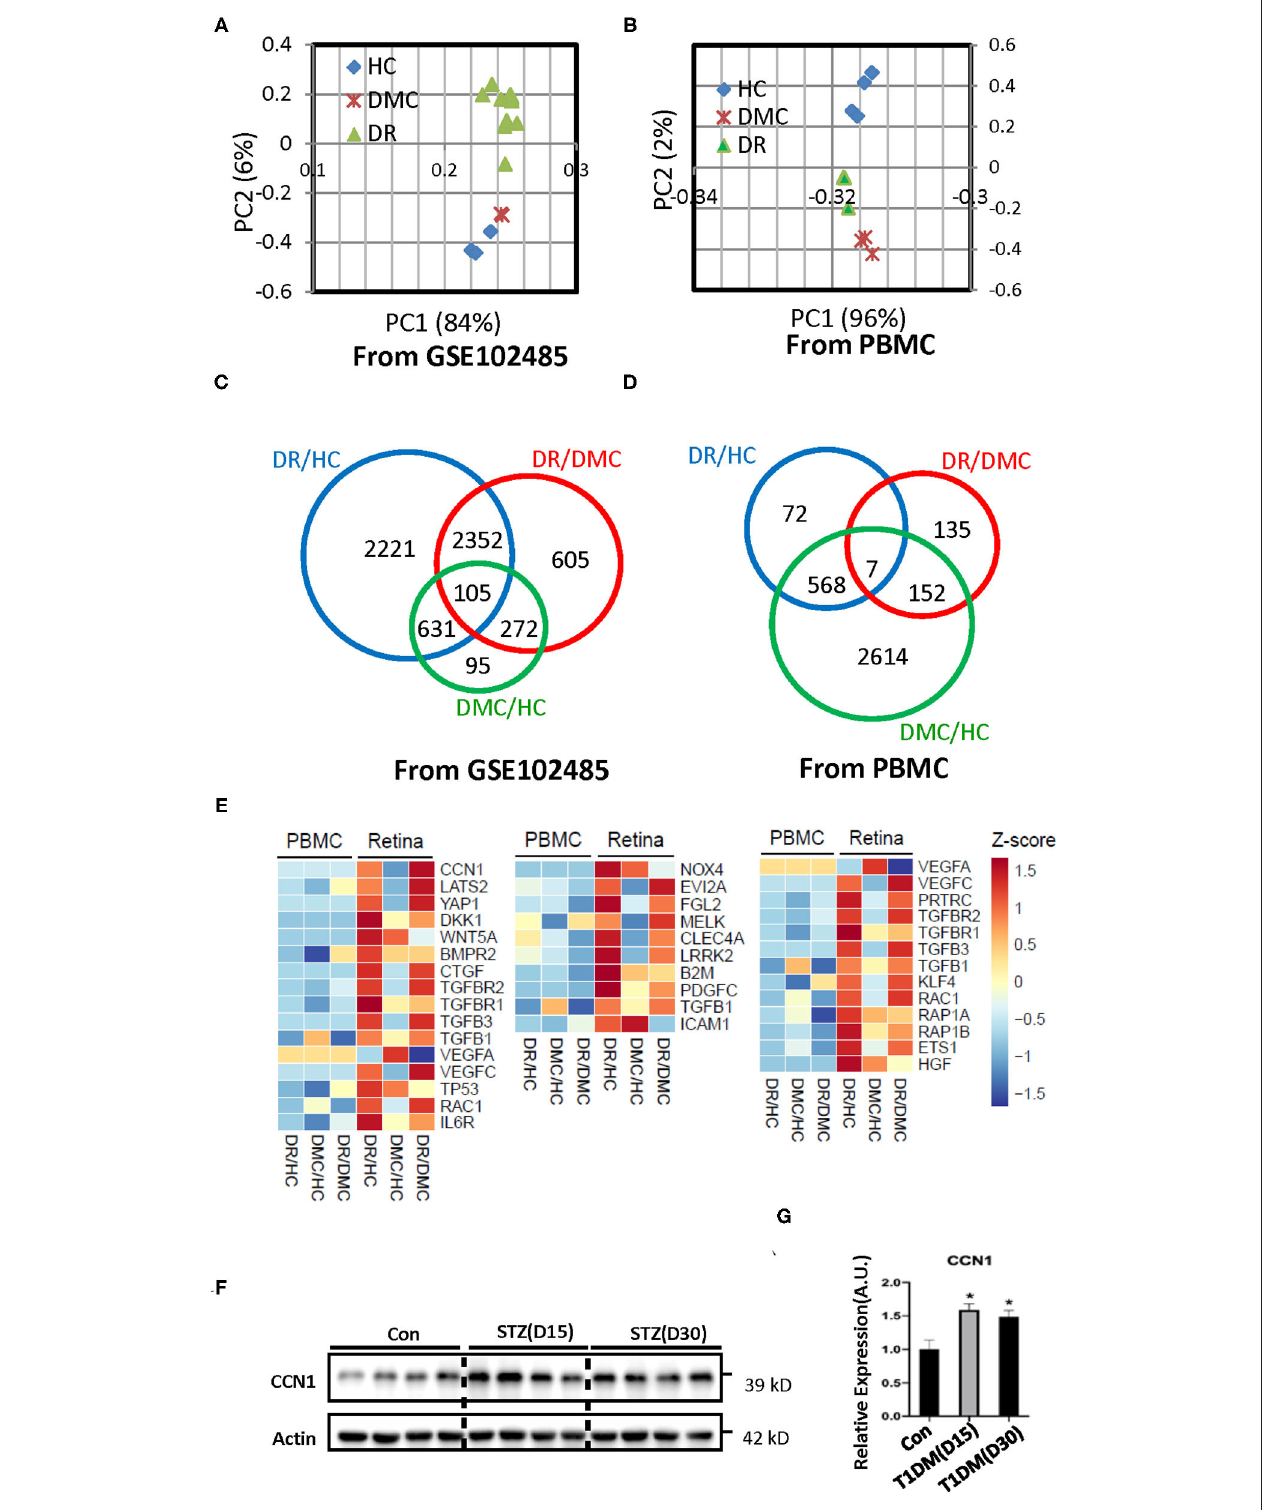
FIGURE 1 | Transcriptome profiles of retina tissue (the raw data of GSE102485) and peripheral blood samples from healthy controls (HCs), the diabetes mellitus control (DMC), and patients with diabetic retinopathy (DR). (A,B) Principal component analysis of the sequenced samples revealed the separation between